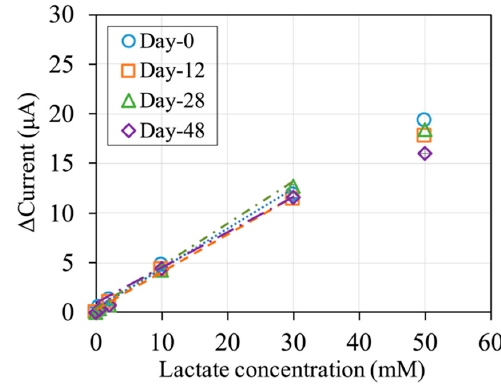
Figure 5. Calibration curves of lactate sensors stored at 25 °C in the dark, evaluated after storage for 2 days (prestorage) + 0, 12, 28, or 48 days. Linear regression was determined for up to 30 mM lactate; sensitivities were 0.38–0.42 μ A/mM (R 2 > 0.99) for all calibration curves. Sensor composition: 5 U Av LOx A96L, 100 nmol mPES, 40 μ g sucrose, and 20 μ g Tween 20. Waiting time: 60 s. Applied potential: +0.2 V vs. Ag/AgCl. N = 3. Sampling point: 10 s.